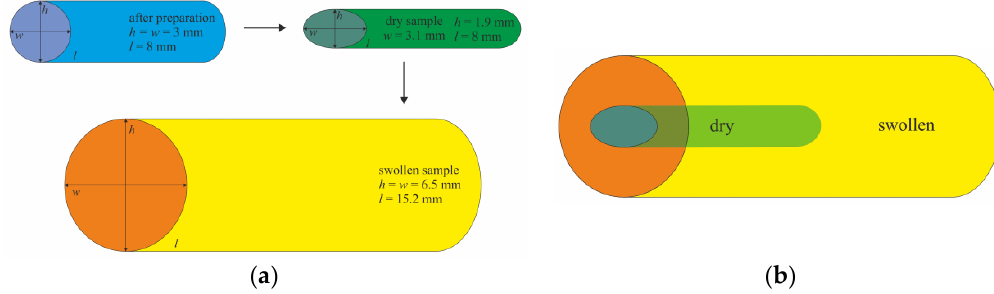
Figure 4. Illustrative images: ( a ) hydrogel anisotropic drying-swelling behavior; ( b ) comparison of the sizes of dried and swollen samples. Table 1. Dimension ratios of hydrogel polySMA-0.7 after swelling in PBS.